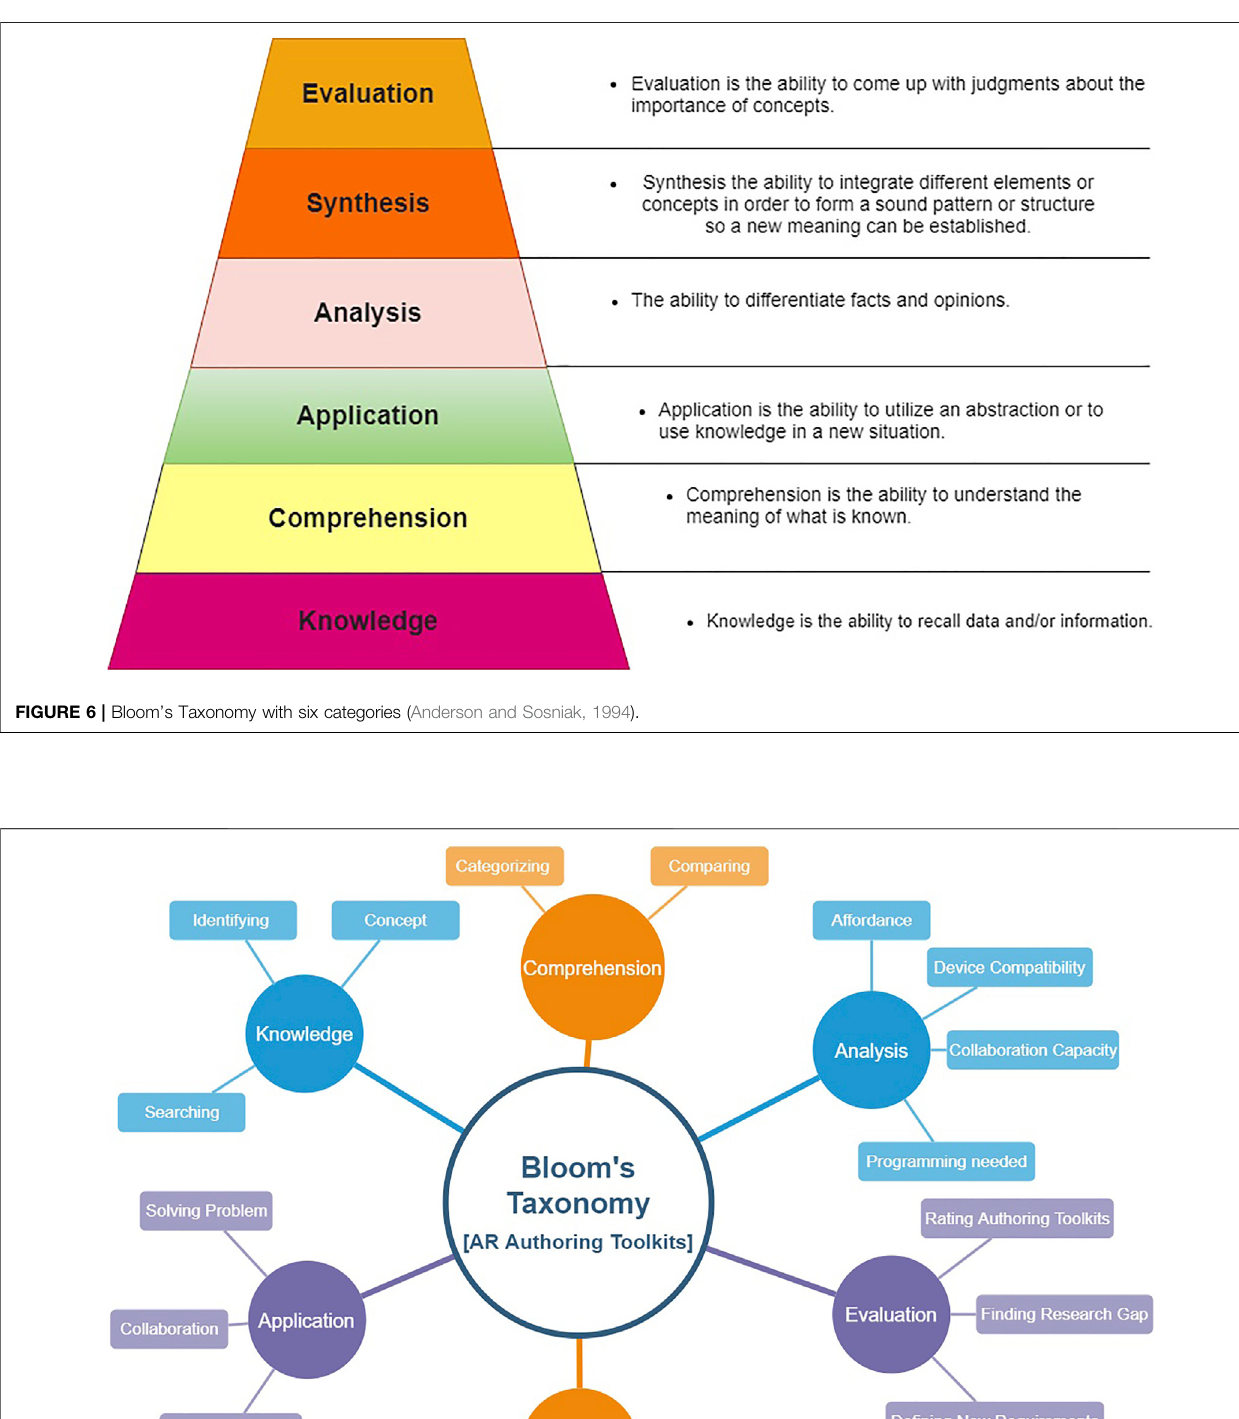
Frontiers in Virtual Reality |